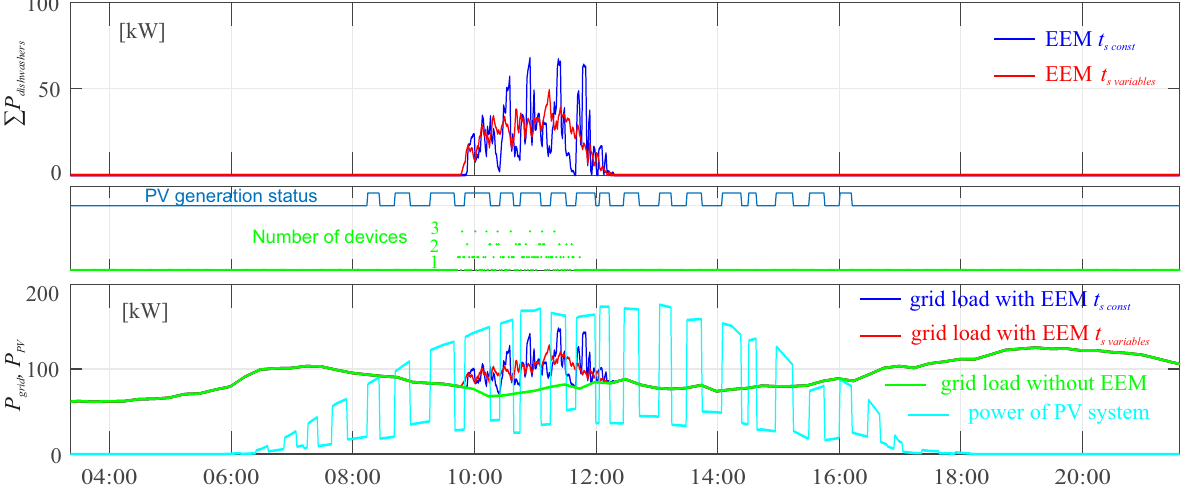
Figure 10. Numerical experiment of electric power systems with PV installation and the elastic energy management algorithm for 100